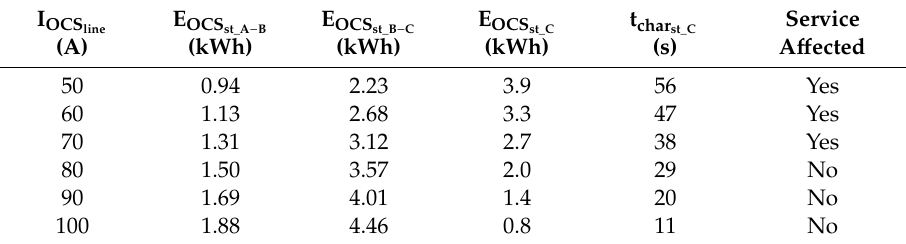
Table 6. Results for the catenary free section between stations C and